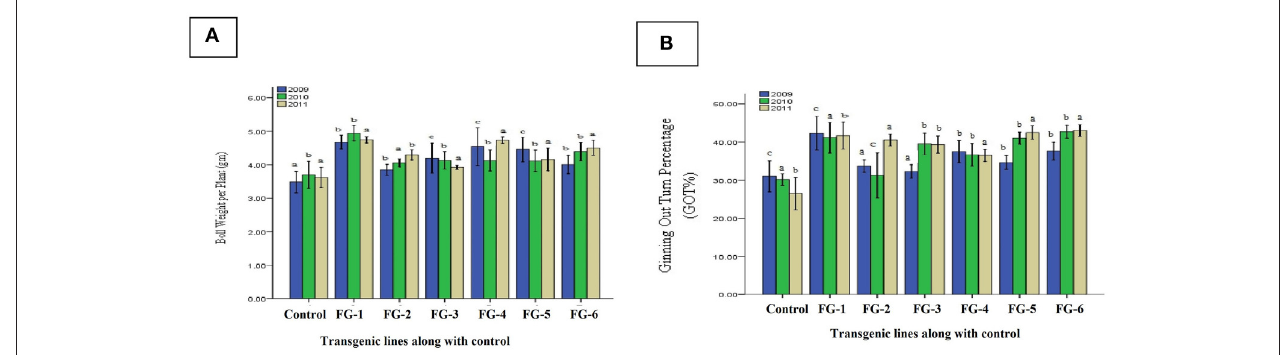
FIGURE 8 | Comparison of boll weight per plant and ginning out turn percentage (GOT%) of transgenic plants. (A) indicate the Boll Weight per Plant and (B) represent the Ginning Out Turn percentage (GOT%) of putative transgenic cotton plants with GhEXPA8 fiber gene for T 0 , T 1 , and T 2 generations in year 2009, 2010, and 2011, blue color represent morphological analysis at T0 generation, green color indicated morphological analysis at T1 generation, brown color highlight morphological analysis at T2 generation, Note: Bar determined the standard error.